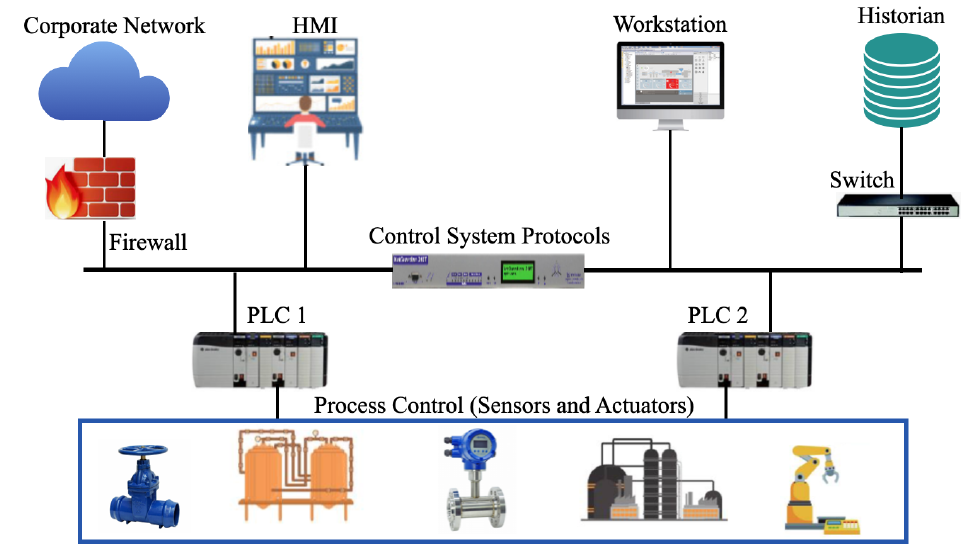
Figure 1. A typical ICS with interconnected network